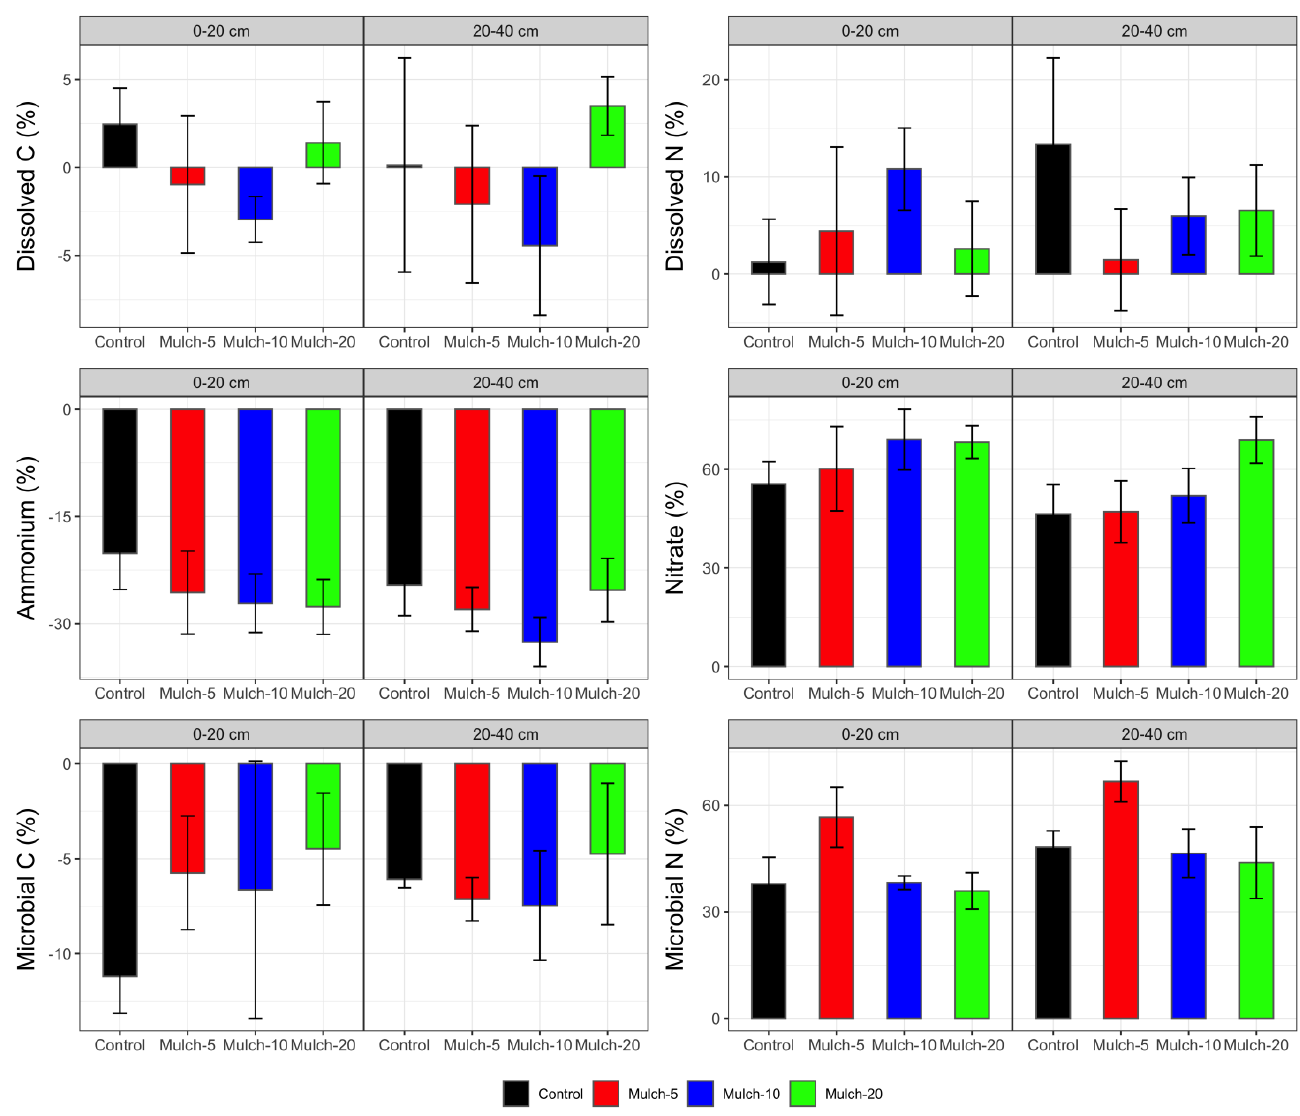
Figure 4. Differences in the C and N fractions between the rhizosphere and bulk soil based on organic mulching. Values represent mean ± standard error ( n = 5). Values above the 0 line indicate higher C and N fraction content in the rhizosphere than in the bulk soil.